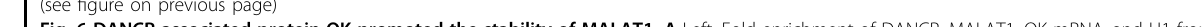
Fig. 6 DANCR-associated protein QK promoted the stability of MALAT1. A Left: Fold enrichment of DANCR, MALAT1, QK mRNA, and U1 from the RIP assay with a QK antibody in HCT116 cells was detected by qPCR. Right: Immunoprecipitation of QK protein from the RIP assay was shown by Western Blotting. B The enrichment of QK protein from the MS2-DANCR RIP assay in HCT116 cells was detected by Western Blotting. MS2, the MS2 RNA-binding protein. DANCR (BS), ectopic expressed DANCR with a tandem sequence of 12-copied MS2-binding site. C The changes in QK protein level upon DANCR knockdown (left) or overexpression (right) in HCT116 and SW620 cells was detected by Western Blotting in the presence or absence of 200 nM Dox for 24 h. ASO, antisense oligonucleotide of DANCR. sh#1/#2, shDANCR#1/#2. D Immuno fl uorescence staining showed the expression of QK protein in HCT116 and SW620 cells with control vector, shDANCR#1, and shDANCR#2. Red: QK, Blue: DAPI. Bar, 20 μ m. E The expression levels of MALAT1 and DANCR in siQK (top) and QK overexpression cells (bottom) of HCT116 and SW620 were detected by qPCR. * p < 0.05. F The dynamic expression changes of MALAT1 and DANCR in siQK and QK overexpression cells of HCT116 and SW620 were detected by qRT-PCR at 0, 3, 6, 9, and 12 h post-treatment with Actinomycin D. * p < 0.05. G The relative enrichment of immunoprecipitated RNAs (% input) from control and shDANCR HCT116 cell lines were compared by qPCR. QK protein in the cell lysate input and in the immunoprecipitate was detected by Western Blotting. * p <